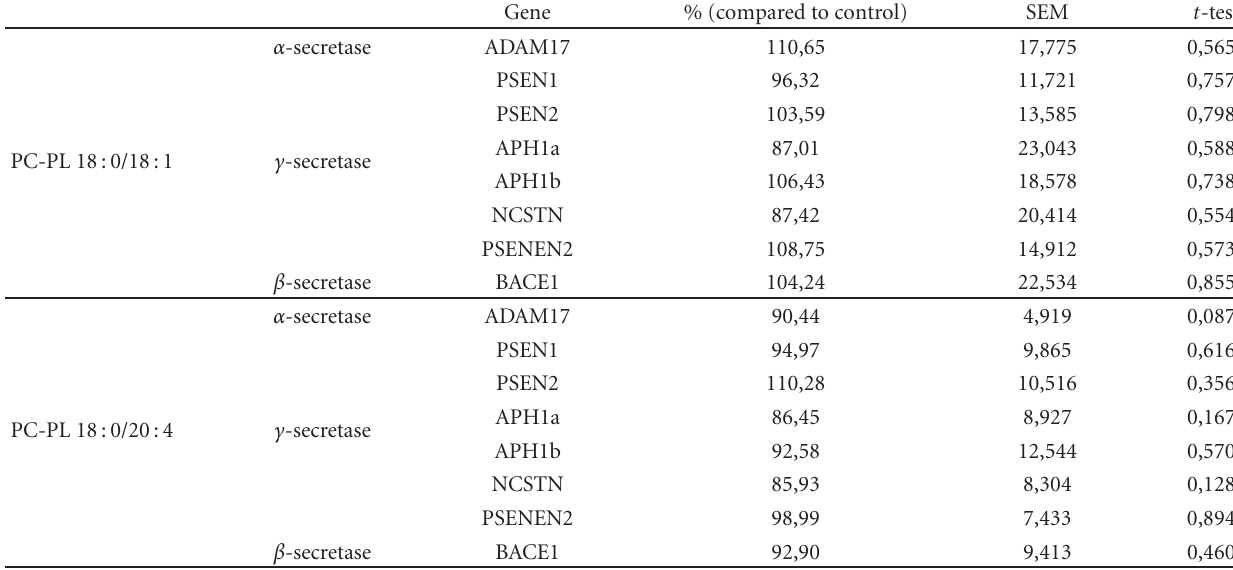
Table 3: RT-PCR analysis of α -secretase ADAM17, the γ -secretase components and β -secretase BACE1 in presence of PC-PL 18:1 and PC- PL 20 :4 compared to the corresponding phospholipids PC 18:1 and PC 20: 4 as control. The abbreviations set are ADAM17 = α -secretase, PSEN1 = presenilin1, PSEN2 = presenilin2, APH1a = anterior pharynx-defective 1a, APH1b = anterior pharynx-defective 1b, NCSTN = nicastrin, PSENEN2 = presenilin enhancer 2, and SEM = standard deviation of the mean. Statistical significance was determined by two- tailed Student’s t